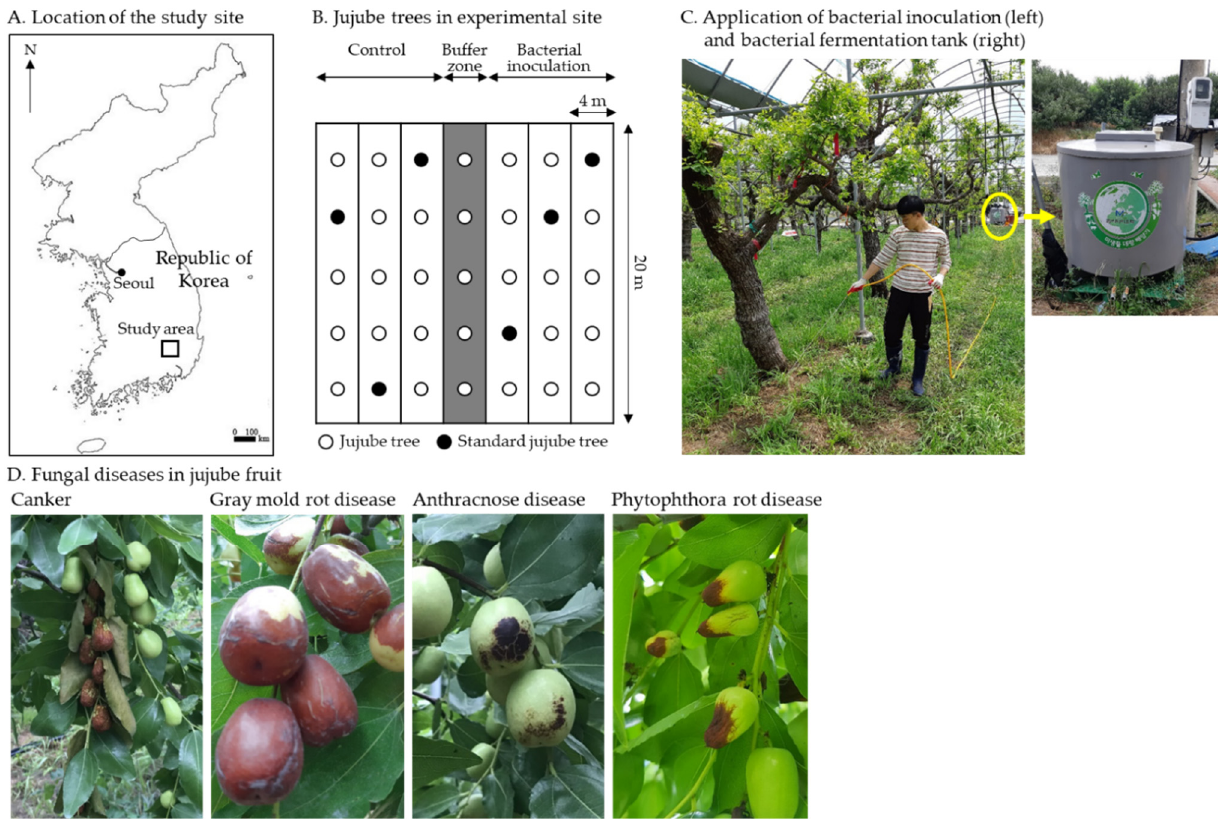
Figure 1. ( A ) Jujube orchard study location; ( B ) Jujube trees in experimental site; ( C ) Application of bacterial inoculation (left) and bacterial fermentation tank (right); ( D ) Jujube fruit fungal diseases, canker disease, gray mold rot caused by Botrytis cinerea , anthracnose caused by Colletotrichum gloeosporioides , and phytophthora fruit rot caused by Phytophthora nicotianae .